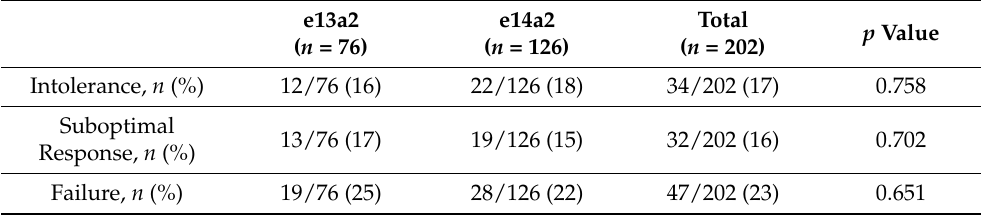
Table 2. Intolerance, suboptimal response, and failure to imatinib treatment according to the tran- script